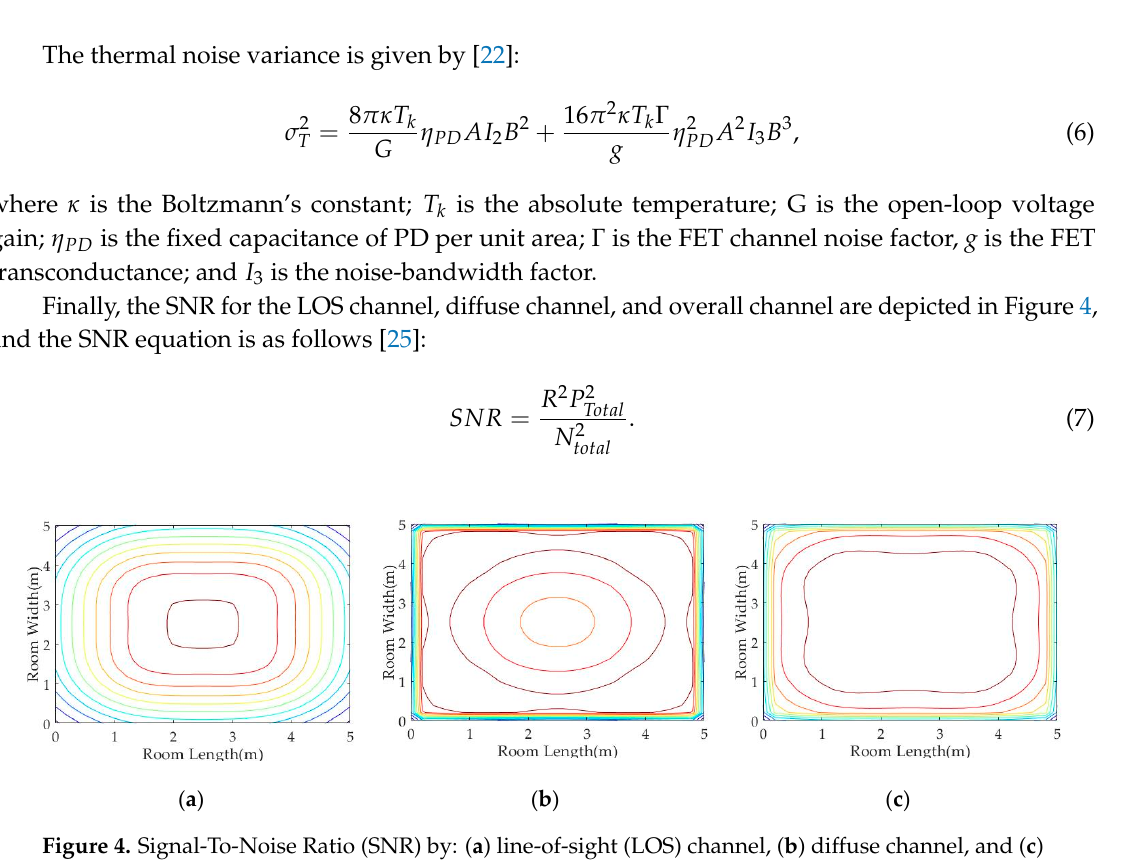
Figure 5. Positioning error using a Trilateration algorithm: ( a ) without multipath reflections and ( b ) with multipath reflections.